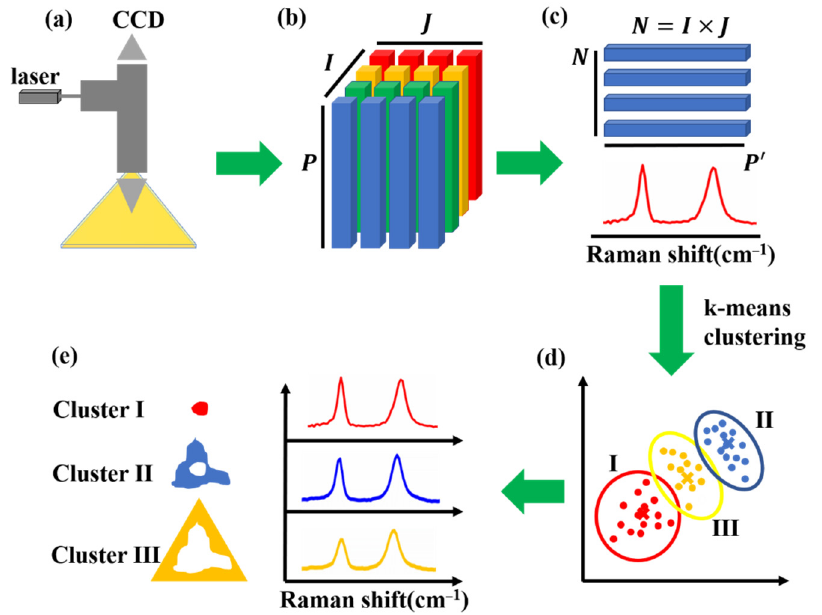
Figure 1. Schematic illustration of the workflow of inhomogeneity visualization in 2D TMD materials, from Raman imaging data acquisition to k-means clustering analysis. ( a ) Experimental setup for collecting Raman data of TMD materials. ( b ) 2D Raman imaging of TMD materials were collected N = I × J total spectra with P = 1600 spectral points in wavenumber unit shown in 3D way. ( c ) Define Raman spectral range with 𝑃′ spectral points for k-means clustering analysis. ( d ) After running k- means clustering, the Raman data was automatically classified into cluster Ⅰ , cluster Ⅱ , and cluster Ⅲ . ( e ) Color-coded cluster spatial maps and the correlated mean spectra of three clusters with iden- tical color.